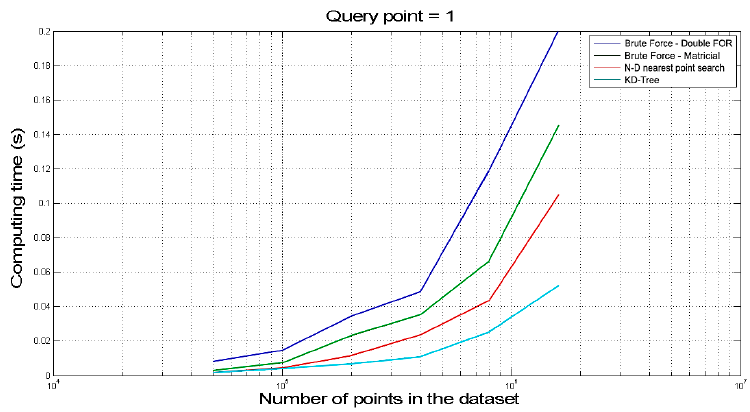
Figure 5. Nearest point methods comparison, 1 query point.